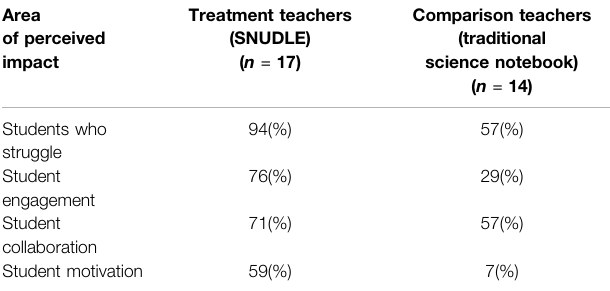
TABLE 6 | Teacher perceptions of positive impact of science notebook use. Area of